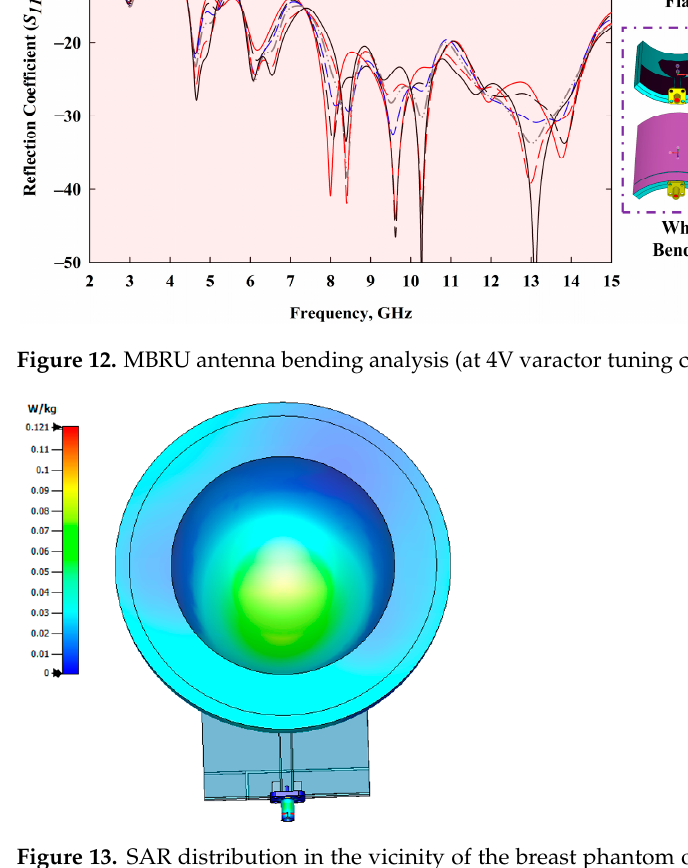
Figure 13. SAR distribution in the vicinity of the breast phantom of the MBRU antenna at 3 GHz under 10 g standard calculation.